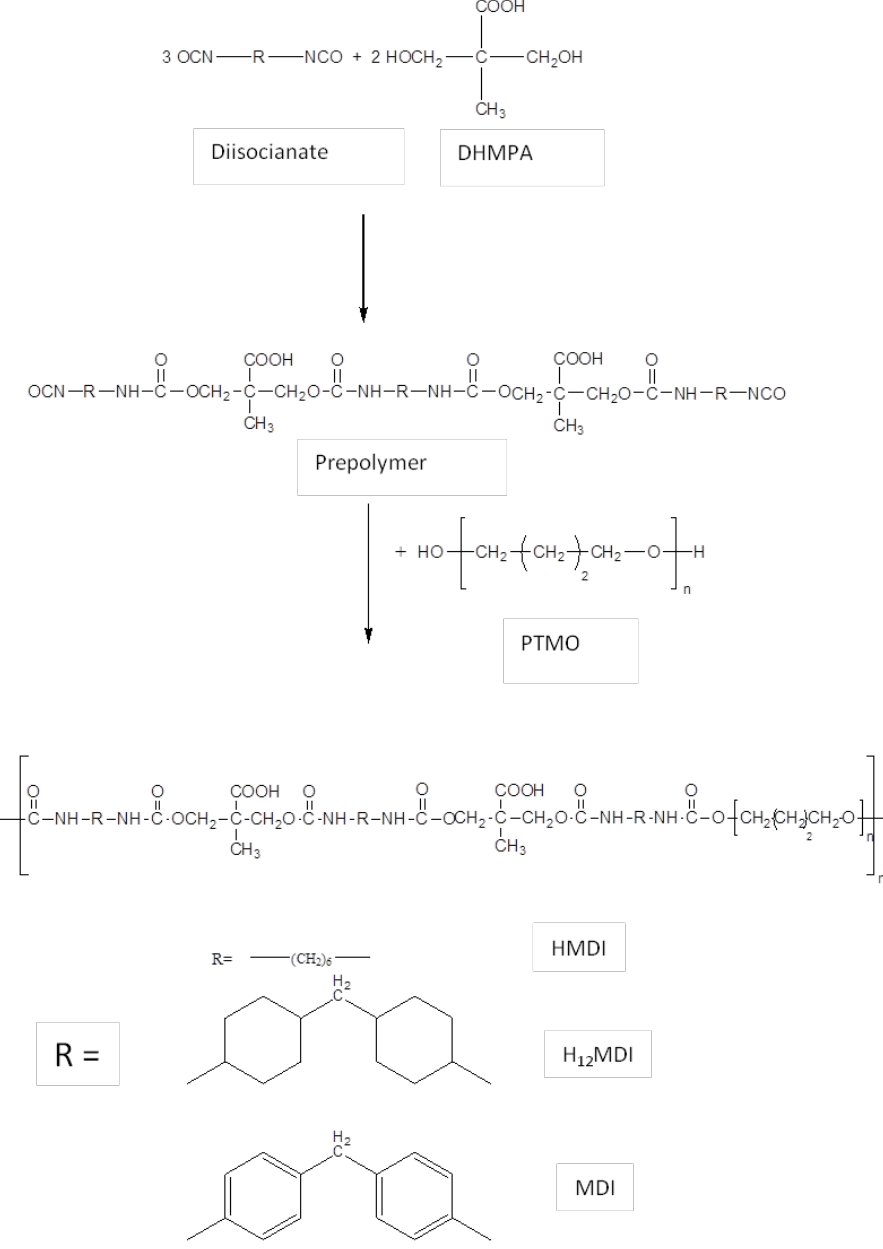
Figure 1. Stages of PU synthesis. Scheme for the diisocyanate:DHMPA:PTMO 3:2:1 molar ratio.